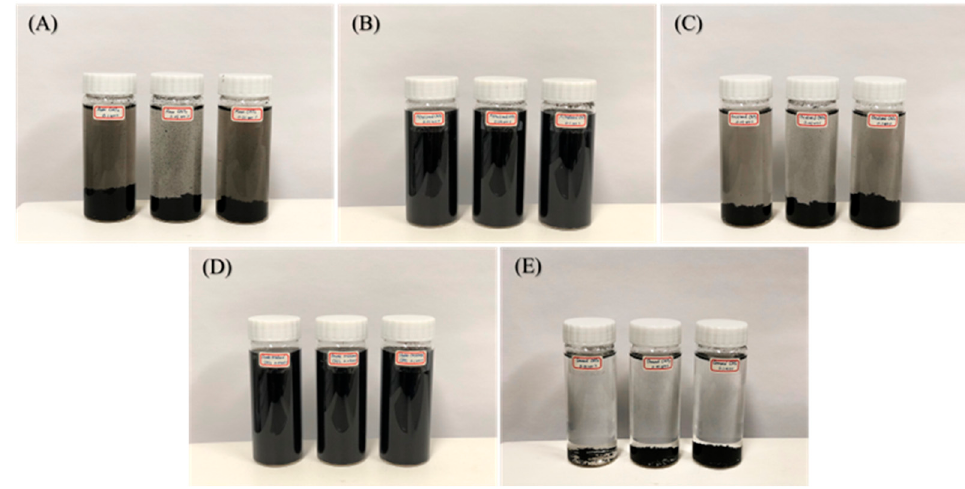
Figure 6. The images of ( A ) RCNT, ( B ) ACNT, ( C ) OCNT, ( D ) DOCNT, and ( E ) GCNT nanofluids by concentration at 0.01, 0.05, and 0.1 wt%.